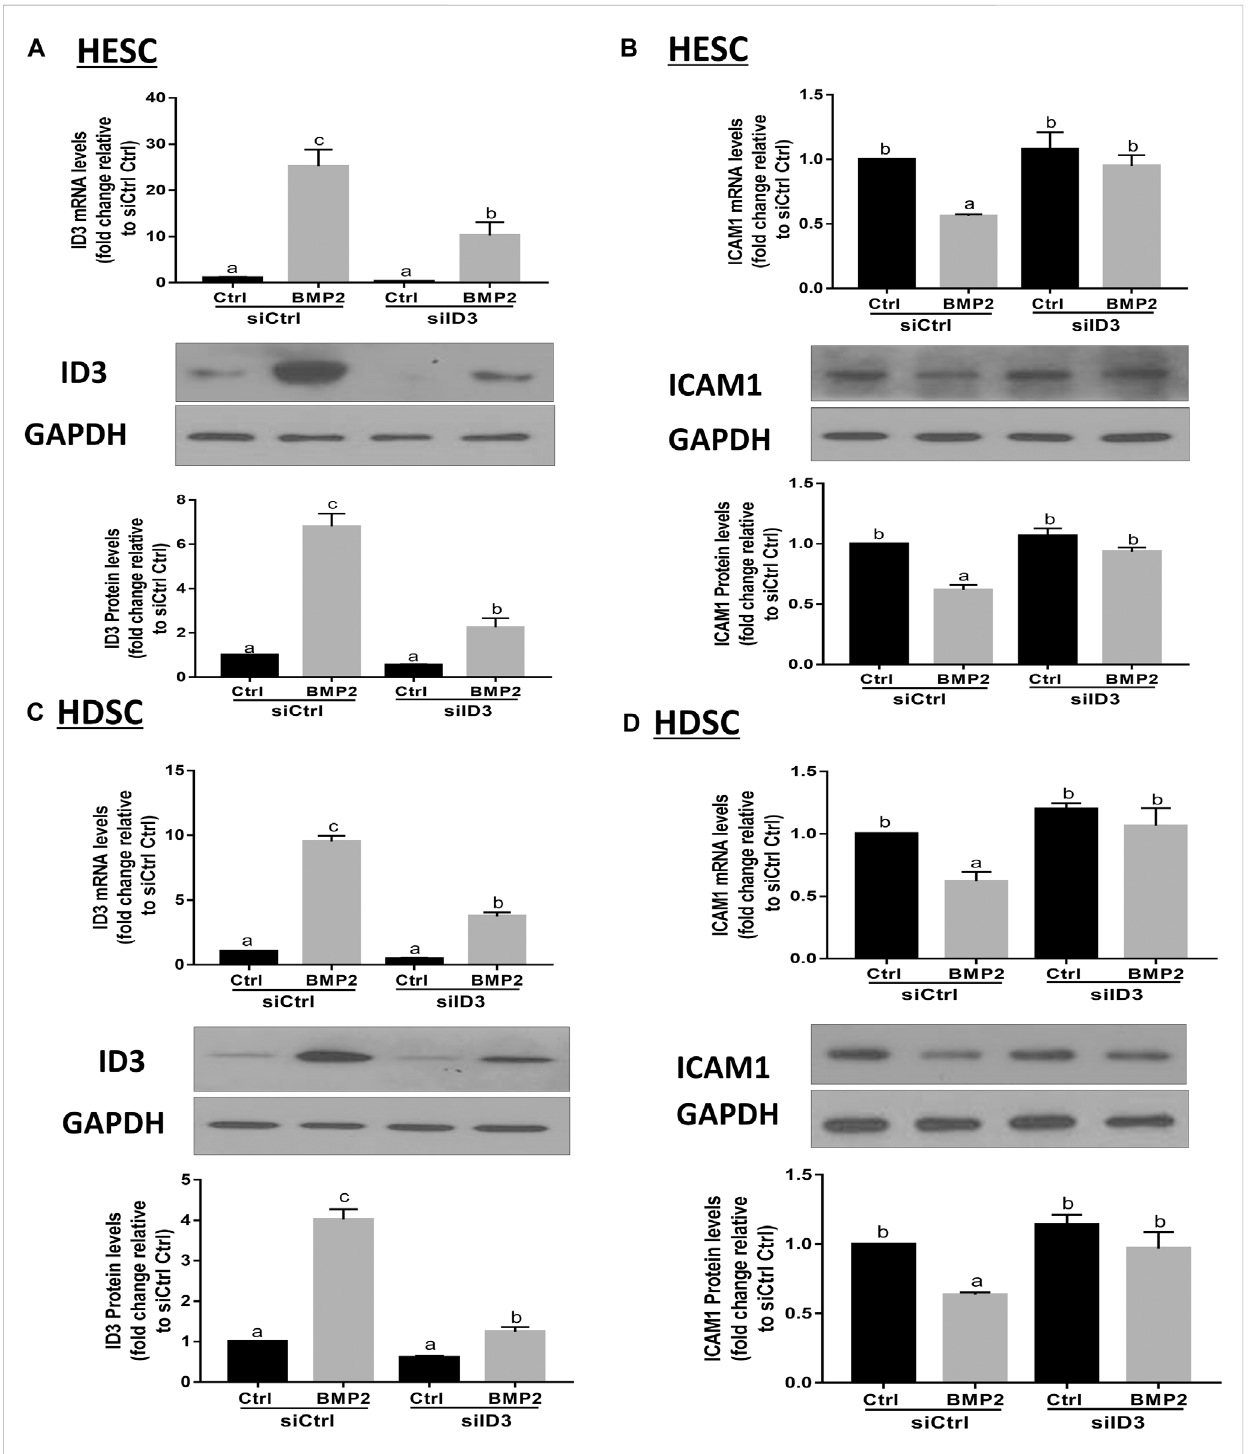
FIGURE 6 ID3mediatestheBMP2-induceddownregulationofICAM1expressioninHESCsandHDSCs. (A,B) HESCsweretransfectedwith25 nMcontrolsiRNA (siCtrl) or 25 nM siRNA targeting ID3 (siID3) for 48 h, and the cells were then treated with vehicle control (Ctrl) or 25 ng/mL BMP2 for an additional 24 h. The mRNA and protein levels of ID3 (A) and ICAM1 (B) were examined using RT-qPCR and Western blot analysis respectively. (C,D) HDSCs were transfectedwith25 nMsiCtrlor25 nMsiID3for48 h,andthecellswerethentreatedwithCtrlor25 ng/mlofBMP2foranadditional24 h.ThemRNA andproteinlevelsofID3 (C) andICAM1 (D) wereexaminedusingRT-qPCRandWesternblotanalysis,respectively.Theresultsareexpressedasthemean± S.E.M. of at least three independent experiments. Different letters indicate signi fi cant a difference ( p <